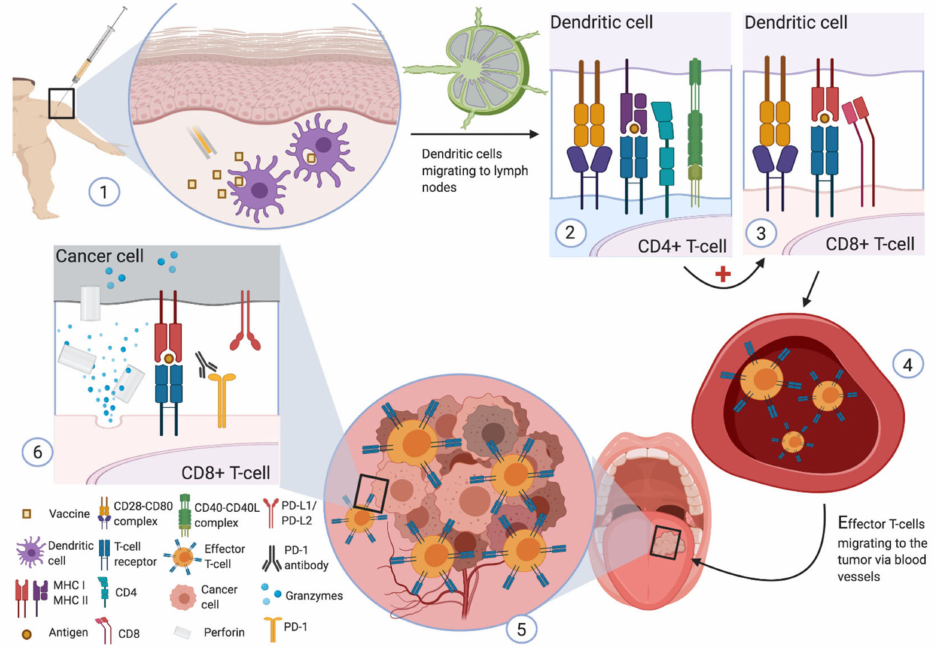
Figure 1. Schematic representation of therapeutic vaccination using a peptide vaccine in a patient with tongue cancer. ( 1 ) Injection of the vaccine subcutaneously containing one or more peptides associated with tumor cells. Vaccine compounds are phagocyted by locally present dendritic cells. After migration of dendritic cells into lymph nodes, stimulation of CD4+ ( 2 ) and CD8+ ( 3 ) T lymphocytes by recognition of the antigens (formed from the vaccine) through interaction between the T cell receptor and the corresponding major histocompatibility complex. CD4+ effector T-lymphocytes produce surface proteins and cytokines for the activation of B lymphocytes, dendritic cells, and macrophages. They are also involved in the production of memory T cells. ( 4 ) Then, effector T-lymphocytes migrate through the blood vessels to the tumor. ( 5 ) Increased lymphocyte infiltration and inflammation within the cancerous tissue. ( 6 ) Tumor antigen recognition by cytotoxic CD8+ T lymphocytes via major histocompatibility complex type I. Activation of cytolytic compounds (as granzymes and perforin) to kill the cancer cells. Note the probable synergistic effect of immune checkpoint inhibitors and therapeutic